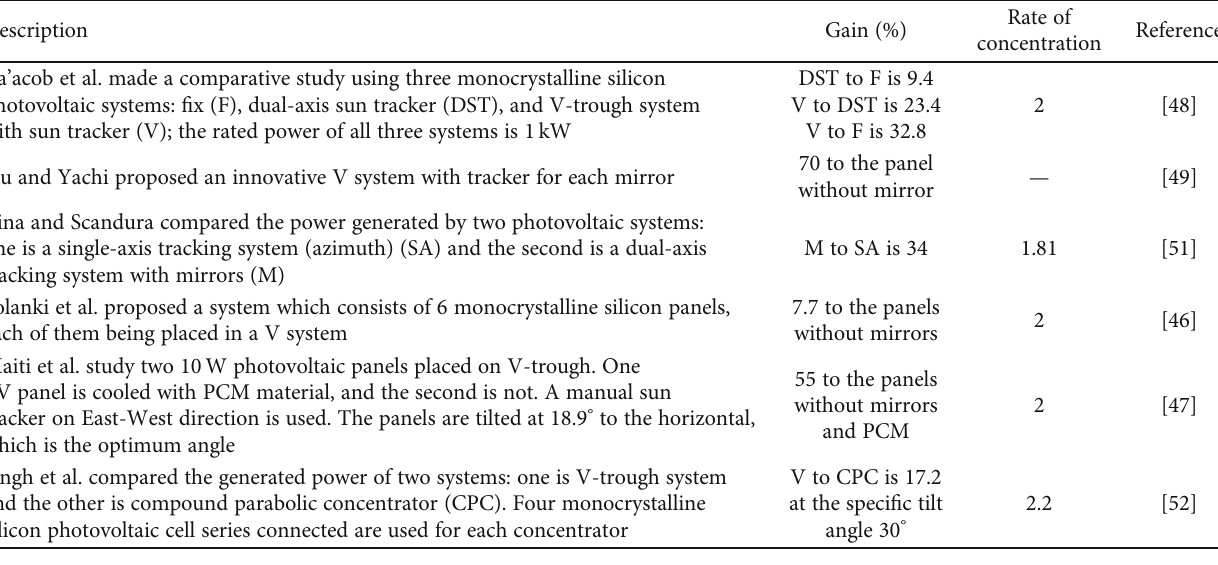
Table 4: V-trough system.